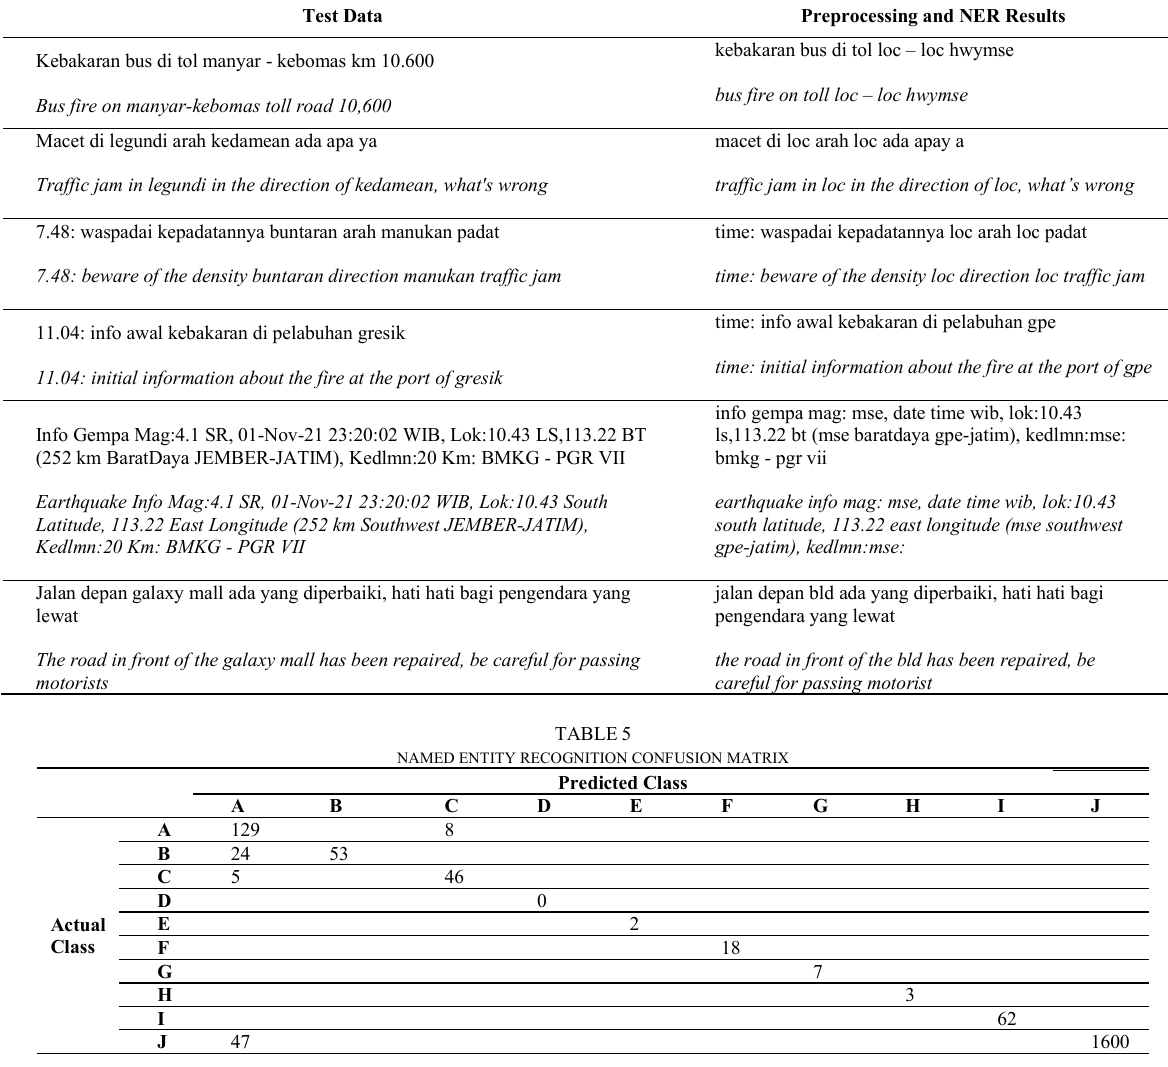
TABLE 4 N AMED E NTITY R ECOGNITION R ESULTS